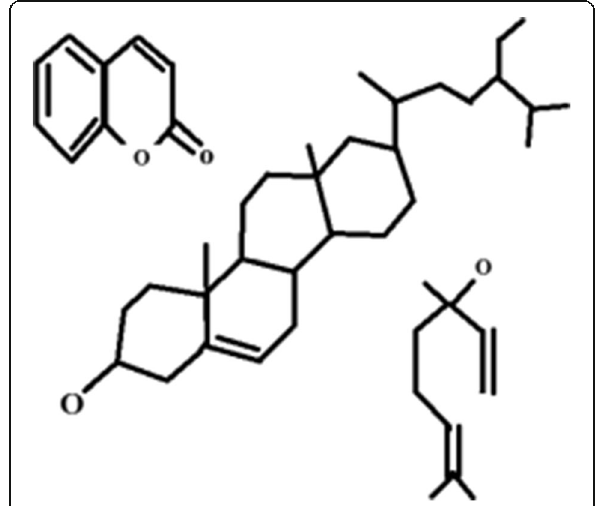
Fig. 7 Chemical structure of Coriander and Linalool